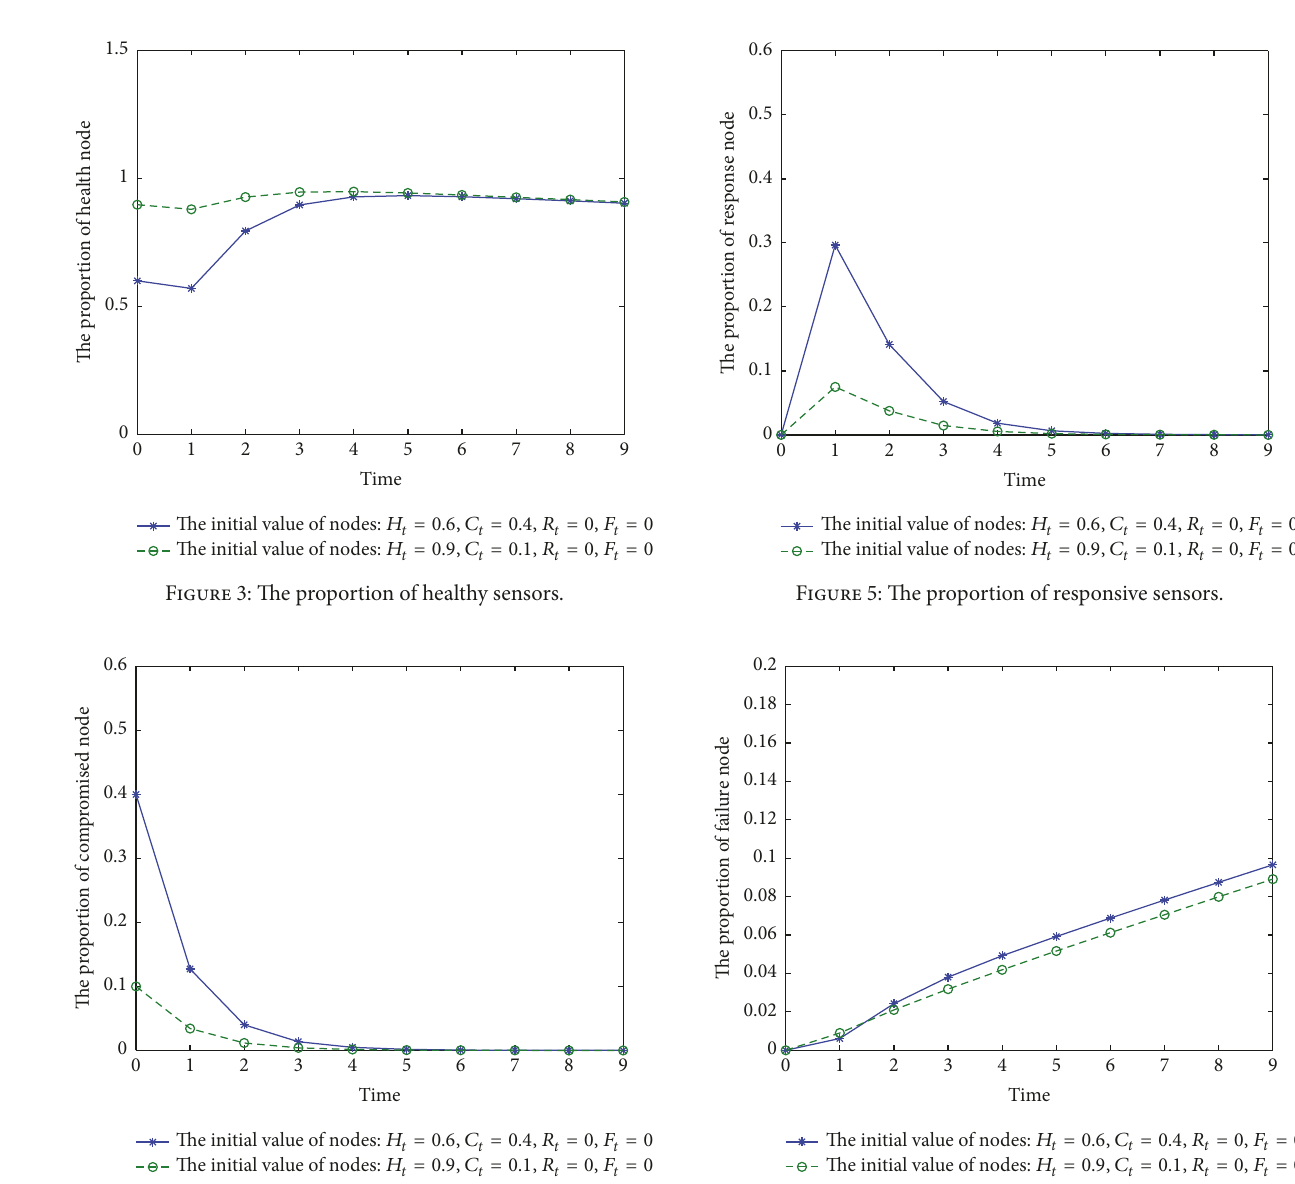
Figure 6: The proportion of failed